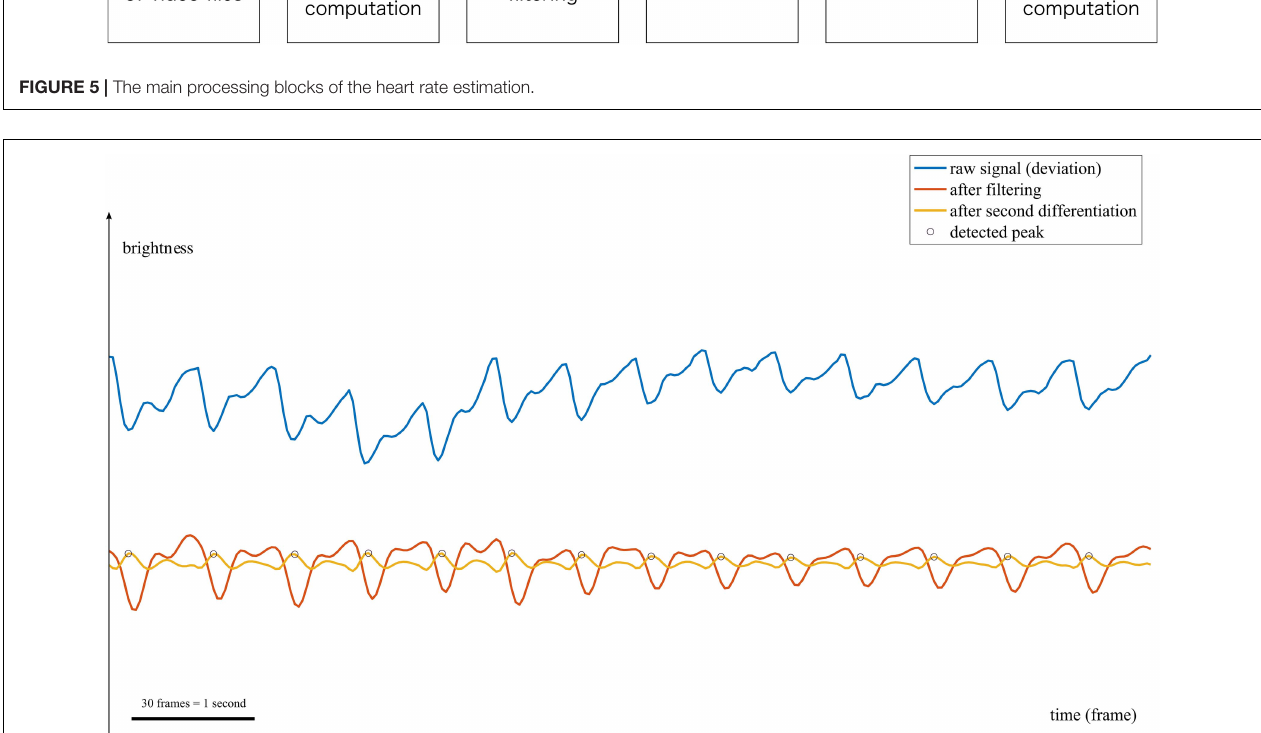
FIGURE 6 | An example of PPG waveforms. The horizontal axis represents time (the sequence of frames in a video file), and the vertical axis represents image brightness reflecting blood flow. The length of the black horizontal bar at the bottom left of the figure corresponds to 30 frames (=1 s). The blue line shows the raw signal in the second block of Figure 5 (each value of brightness on the vertical axis is a deviation from the mean value, that is, the value from which we subtracted its mean value). The red line shows the bandpass-filtered signal in the third block. The yellow line shows the second derivative signal in the fourth block. The black circles show every detected peaks in the fifth